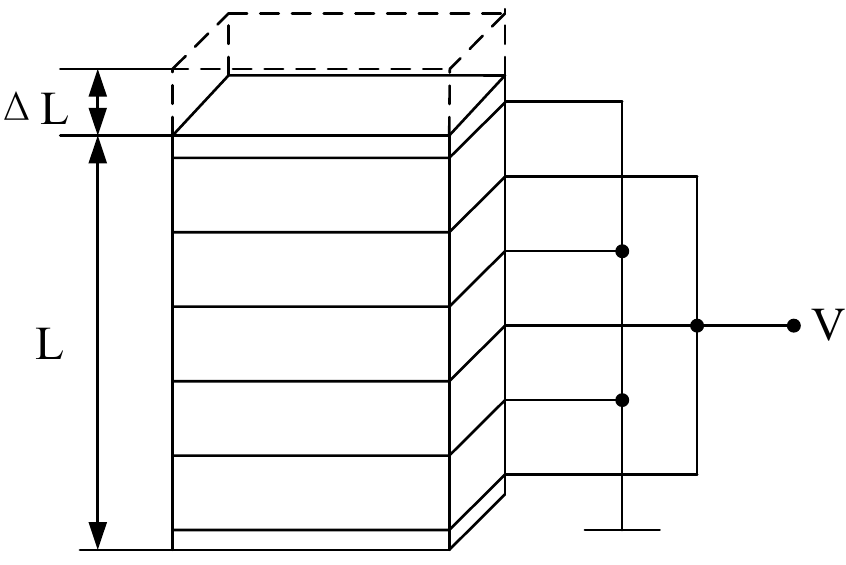
Figure 5. Piezoelectric stack model.